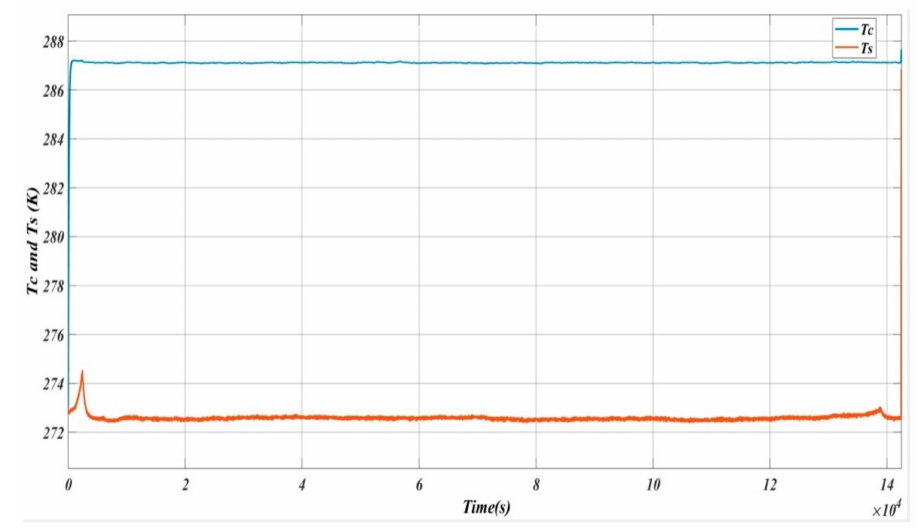
Figure 15. The plot of the estimated T c and measured T s